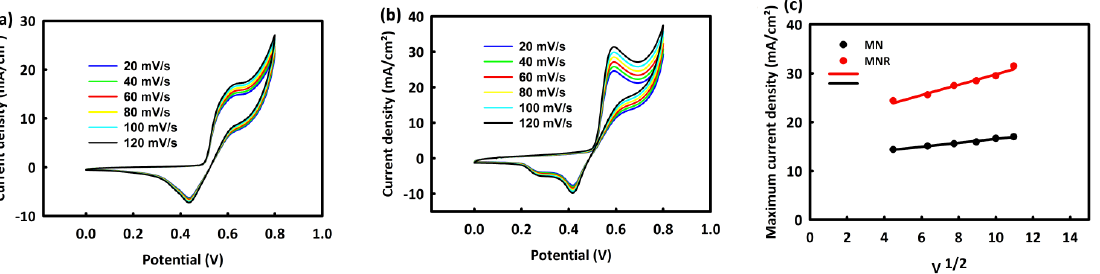
Figure 6. CV curves of MN ( a ) and MNR ( b ) at different scan rates and ( c ) plot of methanol concen- tration versus maximum current density.